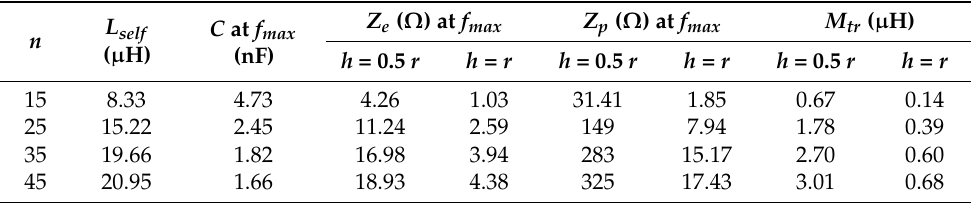
Table 6. Self and mutual inductances as well as compensating capacities and load impedance (at f max ) for square coils and r = 10 mm.